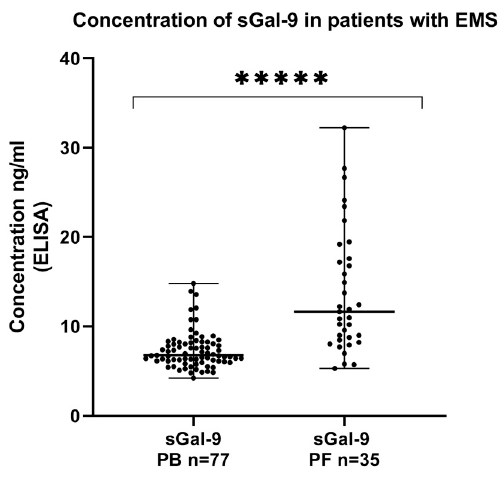
Figure 4. Levels of sGal-9 (ng/mL) in the plasma and peritoneal fluid of patients with endometriosis. The median value with the following signs indicate statistically significant differences: ***** p < 0.00001.